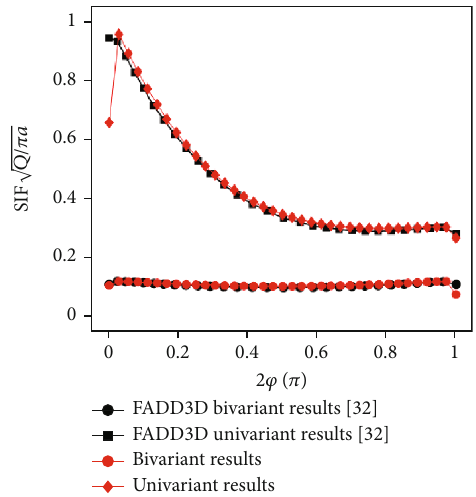
Figure 3: SIF results when cracks under univariant and bivariant stress distributions calculated by FADD3D and ABAQUS